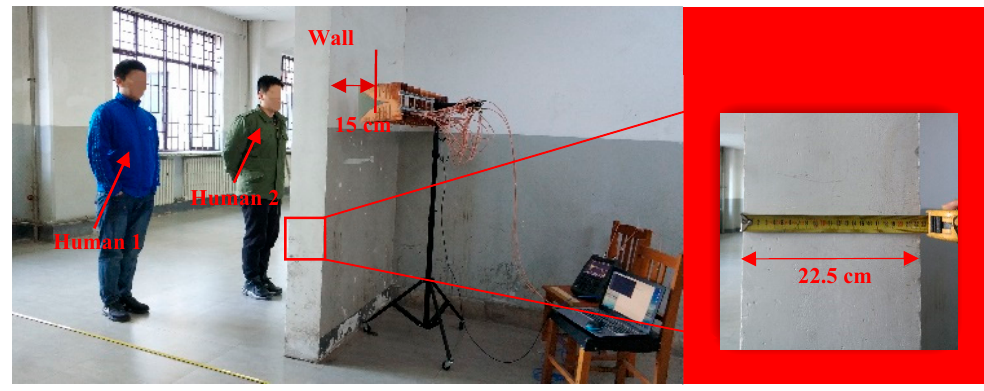
Figure 18. Experimental setup for the through-wall scene.